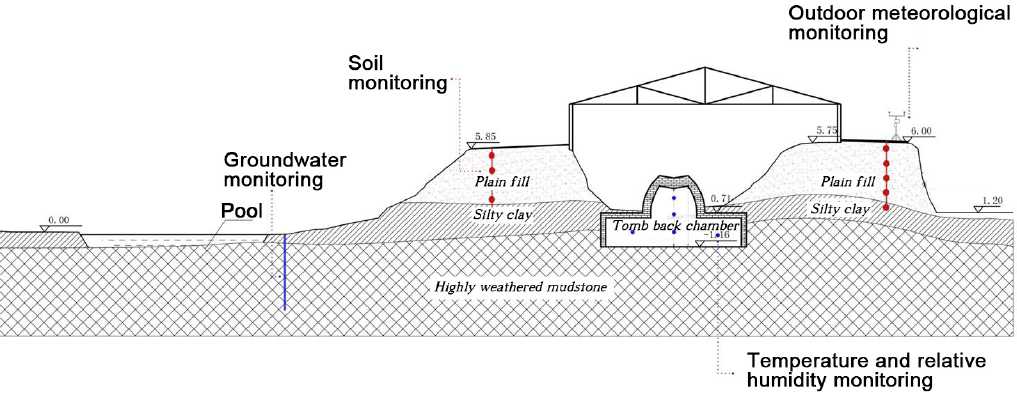
Figure 4. Monitoring scheme.